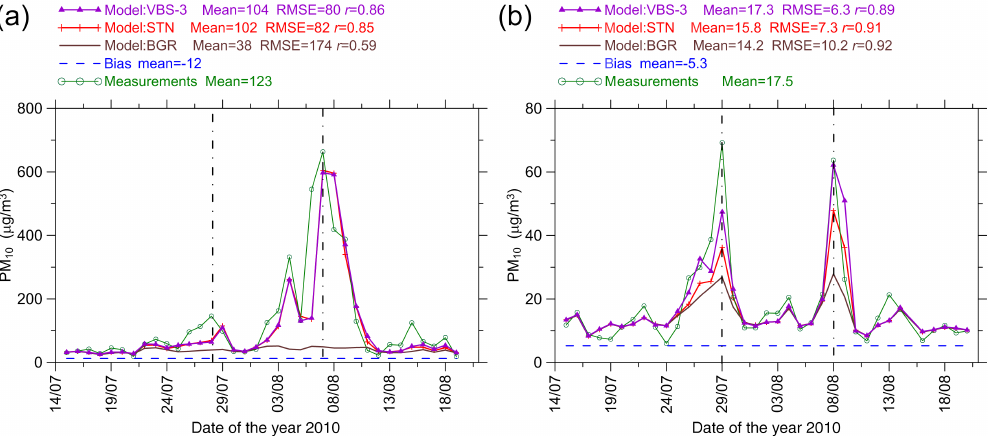
Figure 4. The same as in Fig. 3 but for PM 10 concentrations, except that in addition to results for the STN and BGR runs, this figure also shows (by a purple line) results for the VBS-3